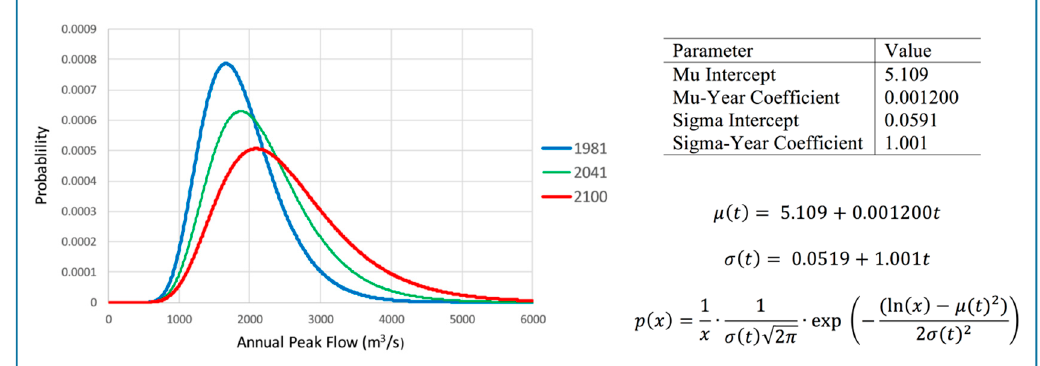
Figure 5. Illustration of a non-stationary LNO distribution fitted to simulated AMS at Fort McMurray station with distribution parameters varying as a function of time ( t ).